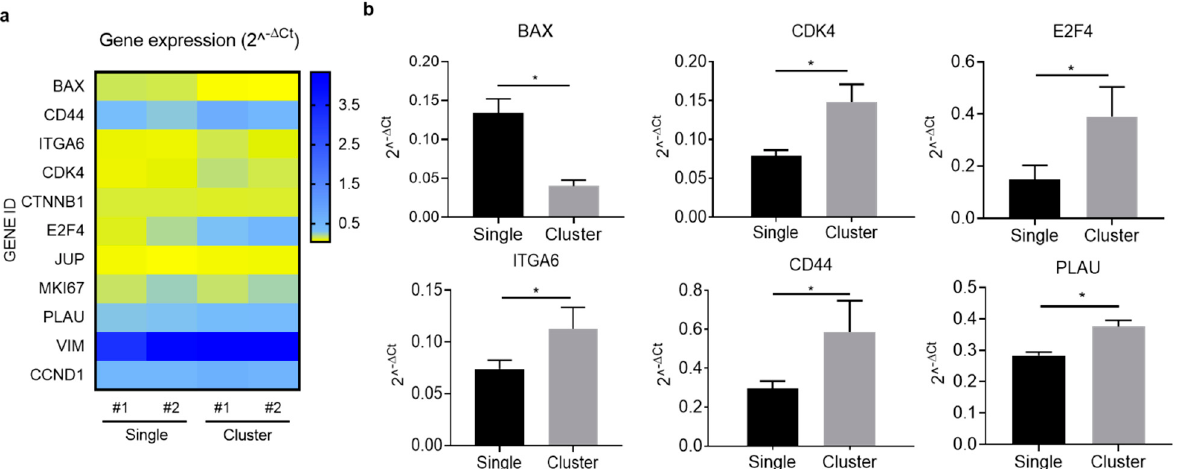
Figure 5. Gene expression profile of the single and cluster cells disseminated in the tail of ZF xenografts. ( a ) Heatmap of the expression levels of disseminated cells in the ZF-single (Sing#1, and Sing#2) and ZF-cluster (Clust#1, and Clust#2) xenografts expressed as 2 − ∆ Ct ; ( b ) Relative mRNA expression observed in the disseminate cells of the ZF-single and ZF-cluster xenografts. Data are expressed relative to the average expression levels of β -2-microglobulin ( β 2M), and Glycer ‐ aldehyde ‐ 3 ‐ Phosphate Dehydrogenase (GAPDH), which were used as the housekeeping genes (* p< 0.05).